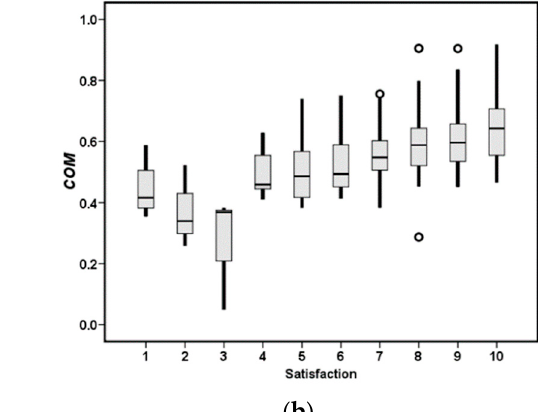
Table 4. COM values with “our” and “my” energy-saving behavior.